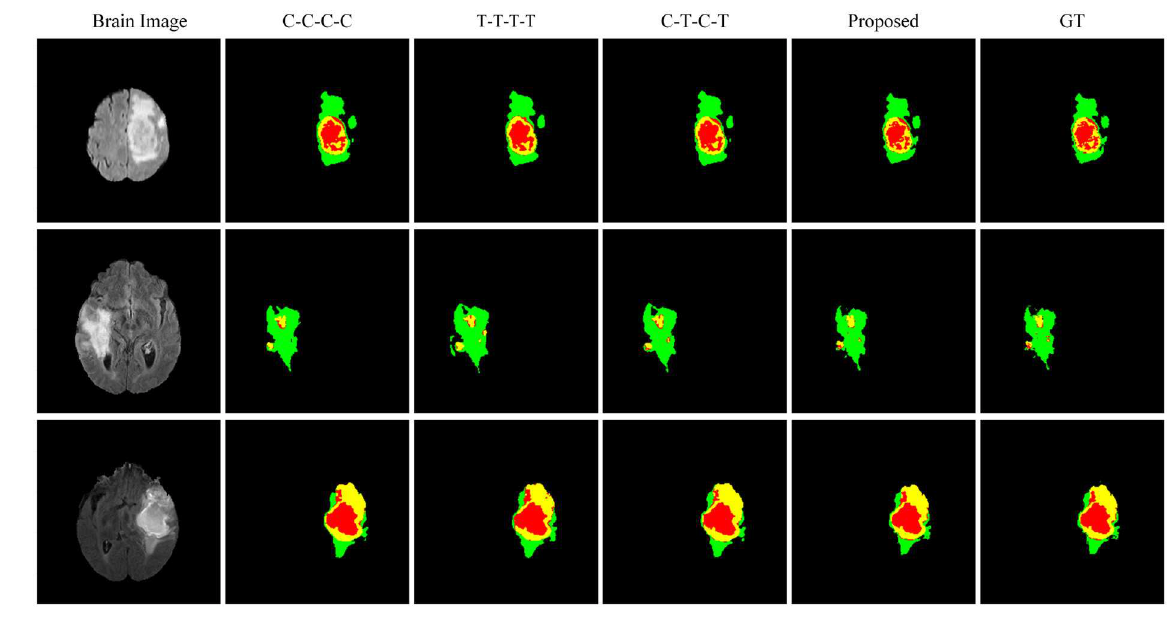
FIGURE6 Visual results of ablation experiments on BraTS2018.